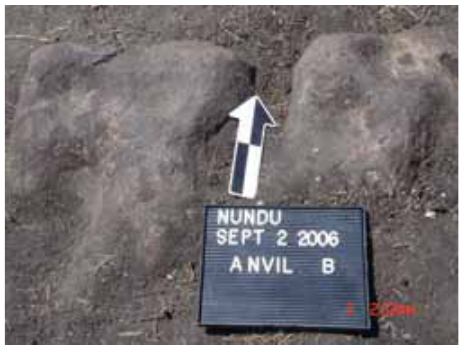
Fig 13: The Small Basaltic Anvils of Nundu